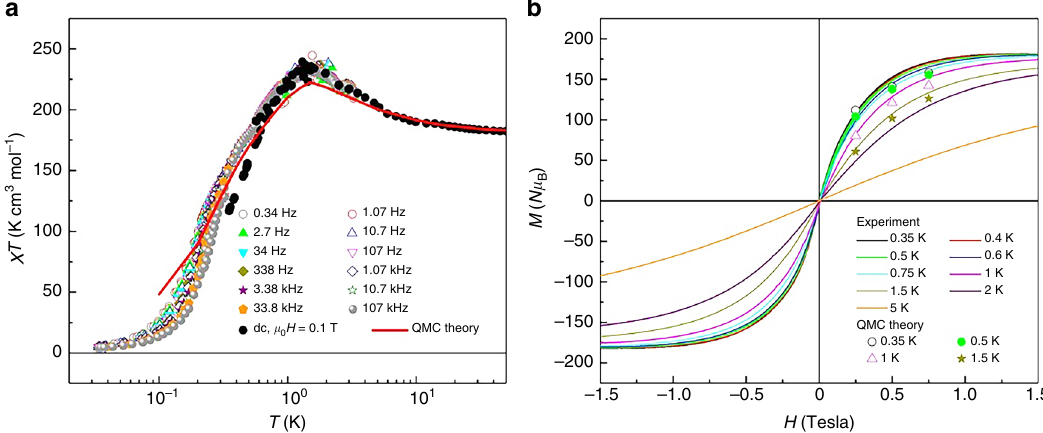
Fig. 3 Very low-temperature magnetic behavior. a Temperature dependence of χ T measured at H = 0 and in the region of very low temperatures for different frequencies. Dc data measured under a magnetic fi eld H = 0.1 T are also shown. Experimental data are represented with symbols, and the solid line represents the best- fi t for the anisotropic model described in the text. b Magnetization versus fi eld isotherms measured at very low temperatures. Solid curves: measured magnetizations at temperatures given. Symbols: QMC calculated magnetizations using the best- fi t parameters given in the text